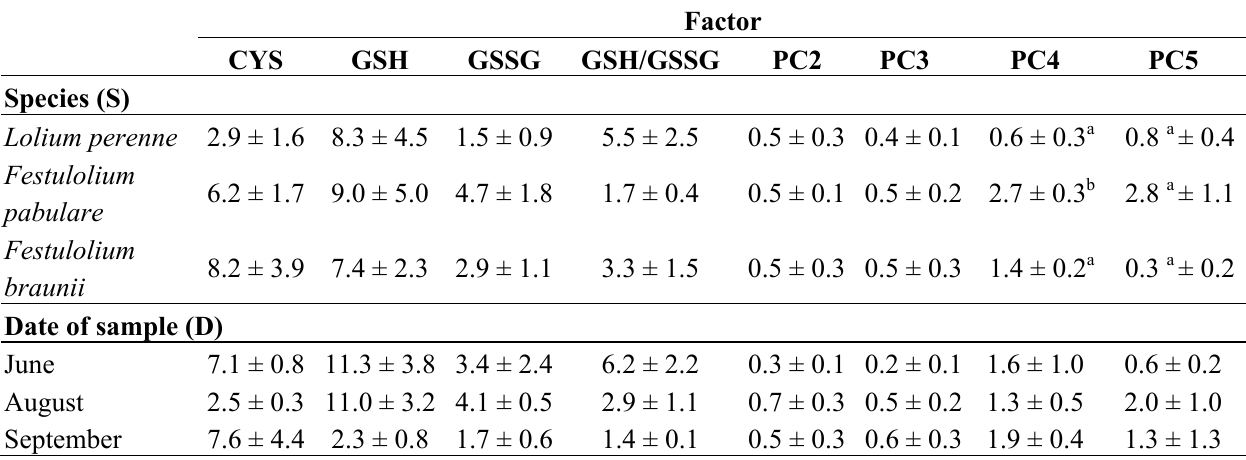
Table 3. Effect of Species (S) and Date of sample (D) on contents of CYS, GSH, GSSG, PC2, PC3, PC4, PC5 and GSH/GSSG ratio in field experiment. Content of CYS, GSH and GSSG is expressed as µg/g of fresh weight. PC2, PC3, PC4 and PC5 are expressed as ng/g of fresh